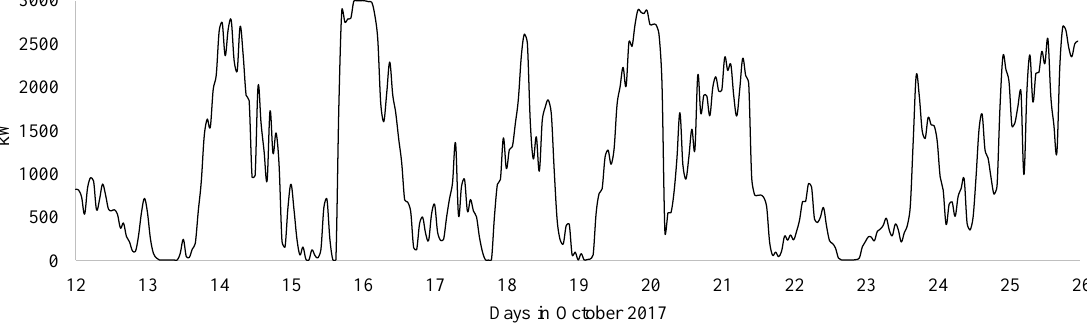
Figure 5. Wind turbine hourly output during a two-week period in October